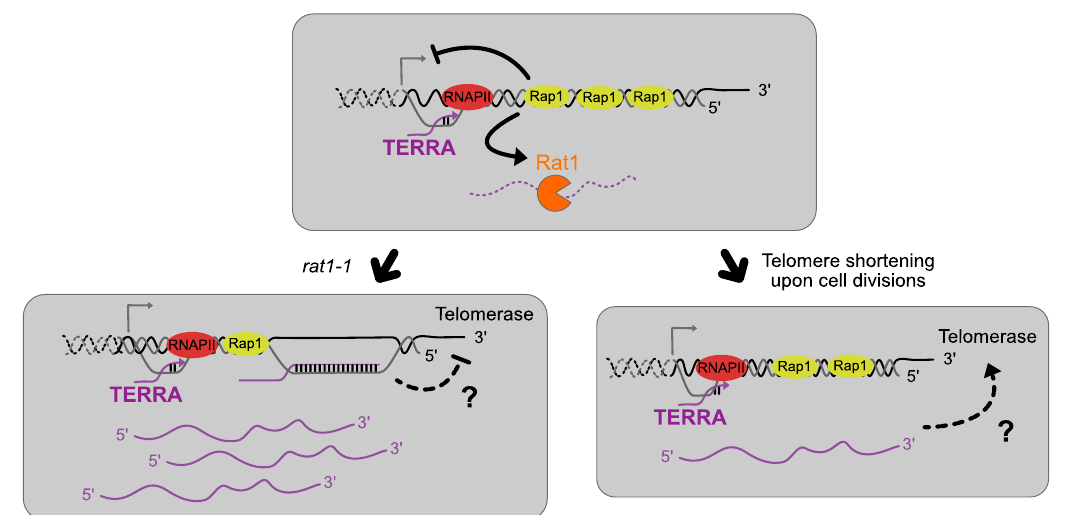
Figure 2. TERRA-telomerase possible interactions. In the absence of Rat1, the main exonuclease responsible for TERRA degradation, TERRA levels increase and are believed to form R-loops with telomeric ends suspected to impair the action of telomerase in elongating short telomeres. On the contrary, when telomeres shorten in a wild-type upon cell divisions, TERRA levels increase because of its cis regulation inhibition but TERRA is still regulated throughout the cell cycle. TERRA would then act as a scaffold molecule by interacting with telomerase to promote the elongation of the shorter telomeres during late S phase.